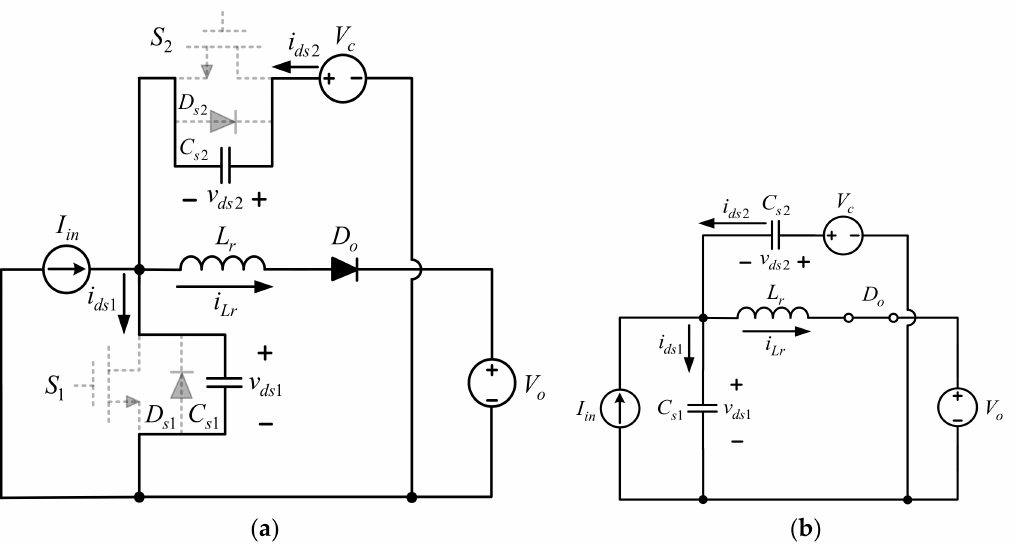
Figure 5. ( a ) Current path for stage 2; ( b ) equivalent of ( a